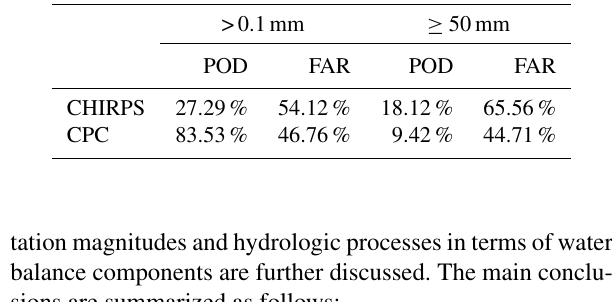
Table 4. POD and FAR values for different rainfall